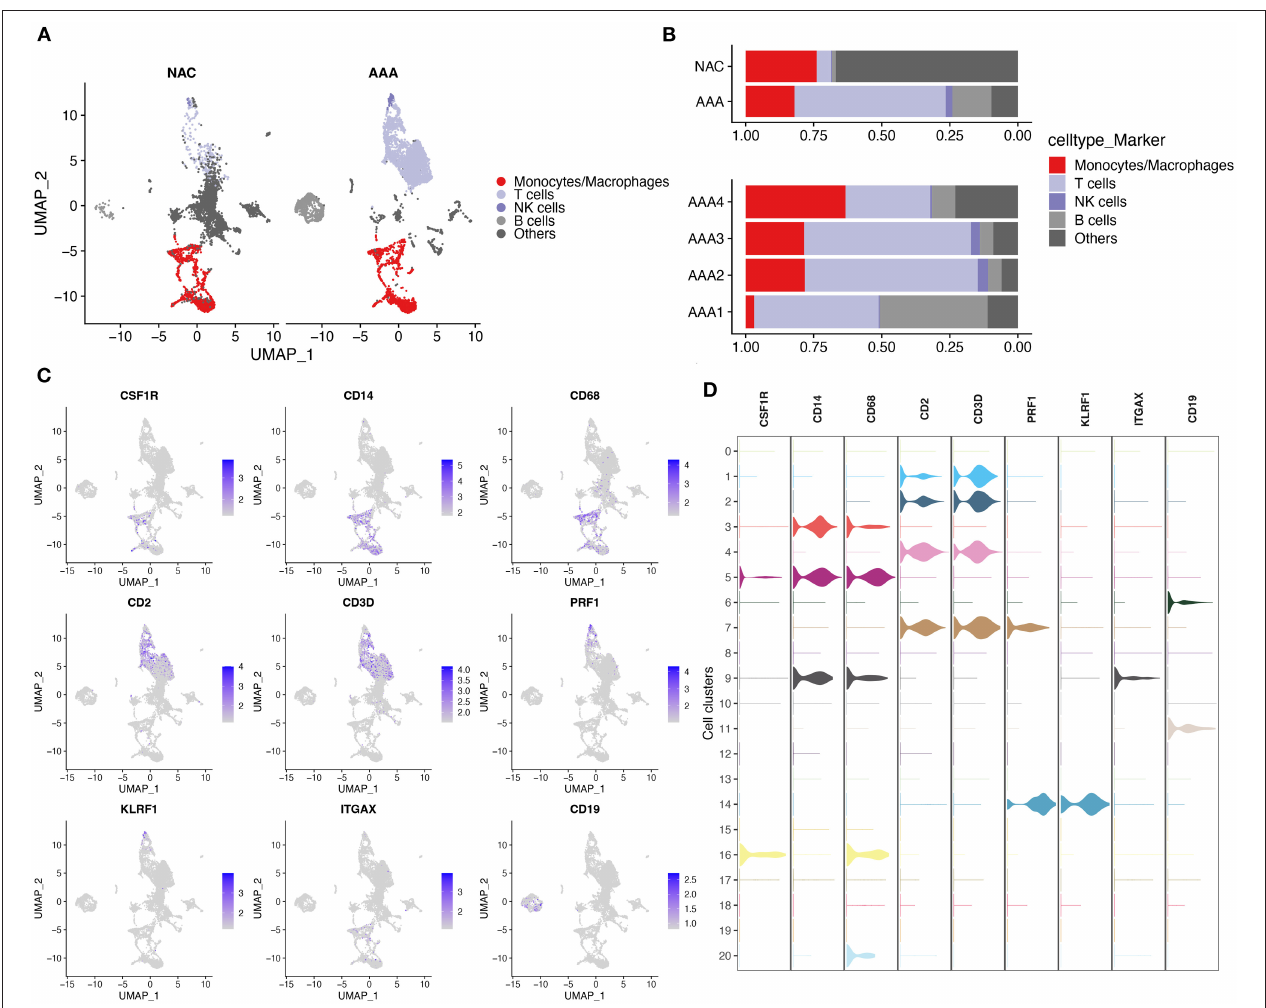
FIGURE 3 | Cell annotation in conjunction with CellMarker. (A) UMAPs show the results of applying the marker genes in CellMaker to annotate cells. (B) The bars depict the percentage of each cell type in each tissue type and patient. (C) UMAPs show the expression of cellular marker genes in cells. (D) Violin diagram depicting cell marker gene expression in each cell